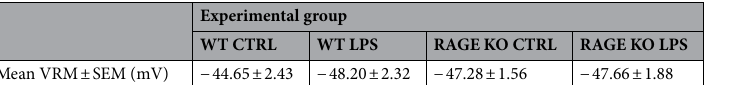
Table 1. Mean resting potentials. Combined mean resting membrane potential of WT and RAGE KO experimental groups recorded by whole-cell patch-clamp electrophysiology. Treatment groups: WT CTL (25); WT LPS (21); RAGE-KO CTL (24), and RAGE-KO LPS (20). Data represented as mean ± SEM. Means were statistically compared by 2-way ANOVA, followed by Tukey’s multiple comparison